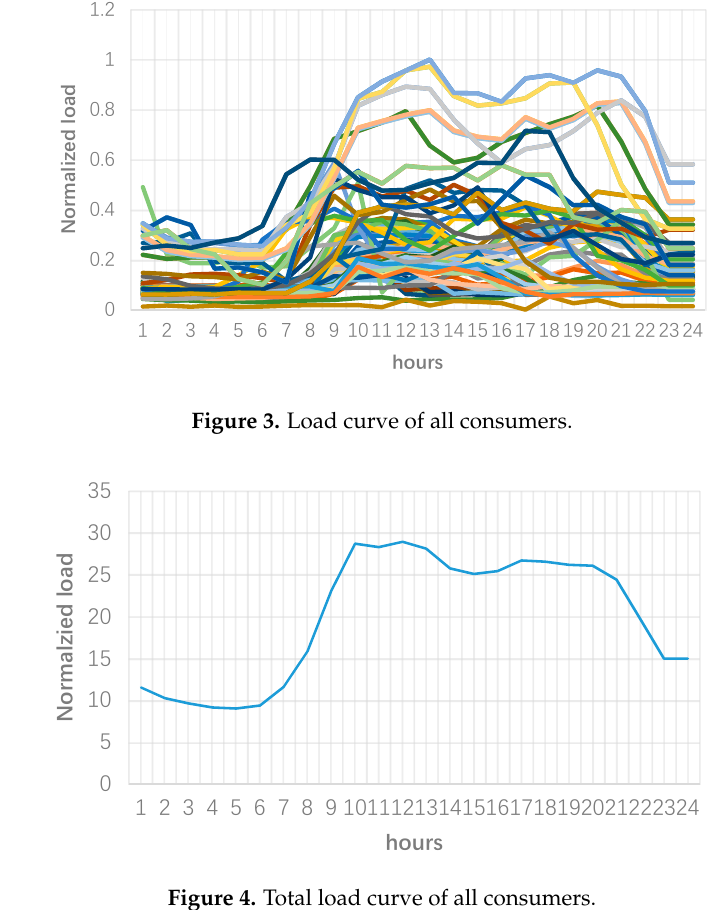
Figure 4. Total load curve of all consumers.